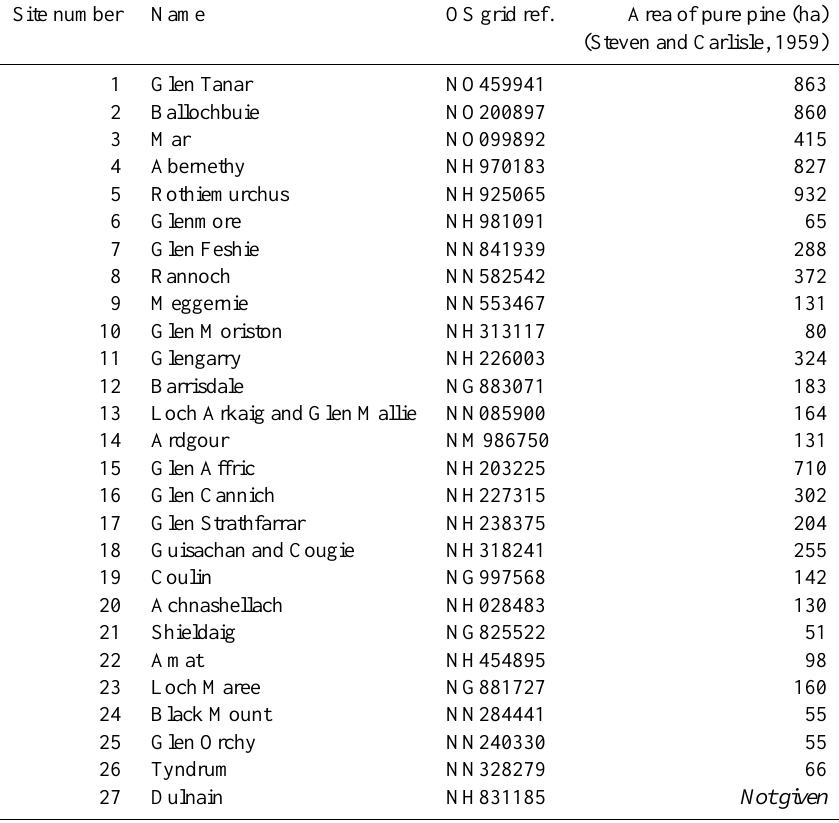
Table 1. List of surveyed pinewoods. Site